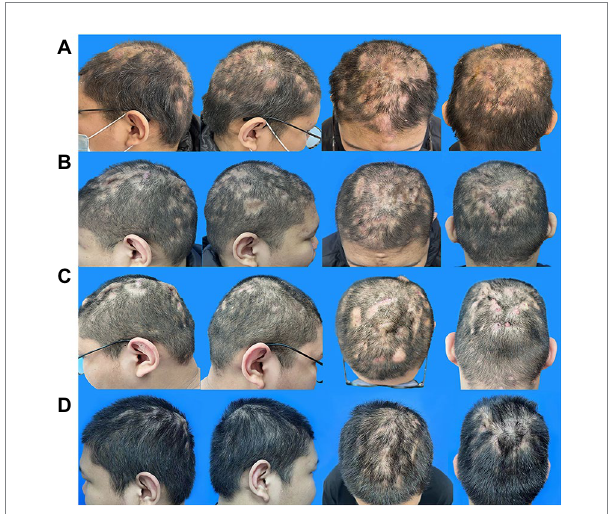
FIGURE 1 Evolution of the scalp manifestation of the PCAS patient. (A) Typical lesions of PCAS on the scalp, nodules, pustules, and alopecia patches prior to adalimumab and isotretinoin therapy on 17 February 2022. (B) After 1 month of treatment with adalimumab and isotretinoin on 24 March 2022. (C) After 5 months of treatment with adalimumab and isotretinoin on 23 July 2022. (D) After changing the treatment regimen to adalimumab and baricitinib for 4 months on November 20, 2022. PCAS, Perifolliculitis capitis abscedens et